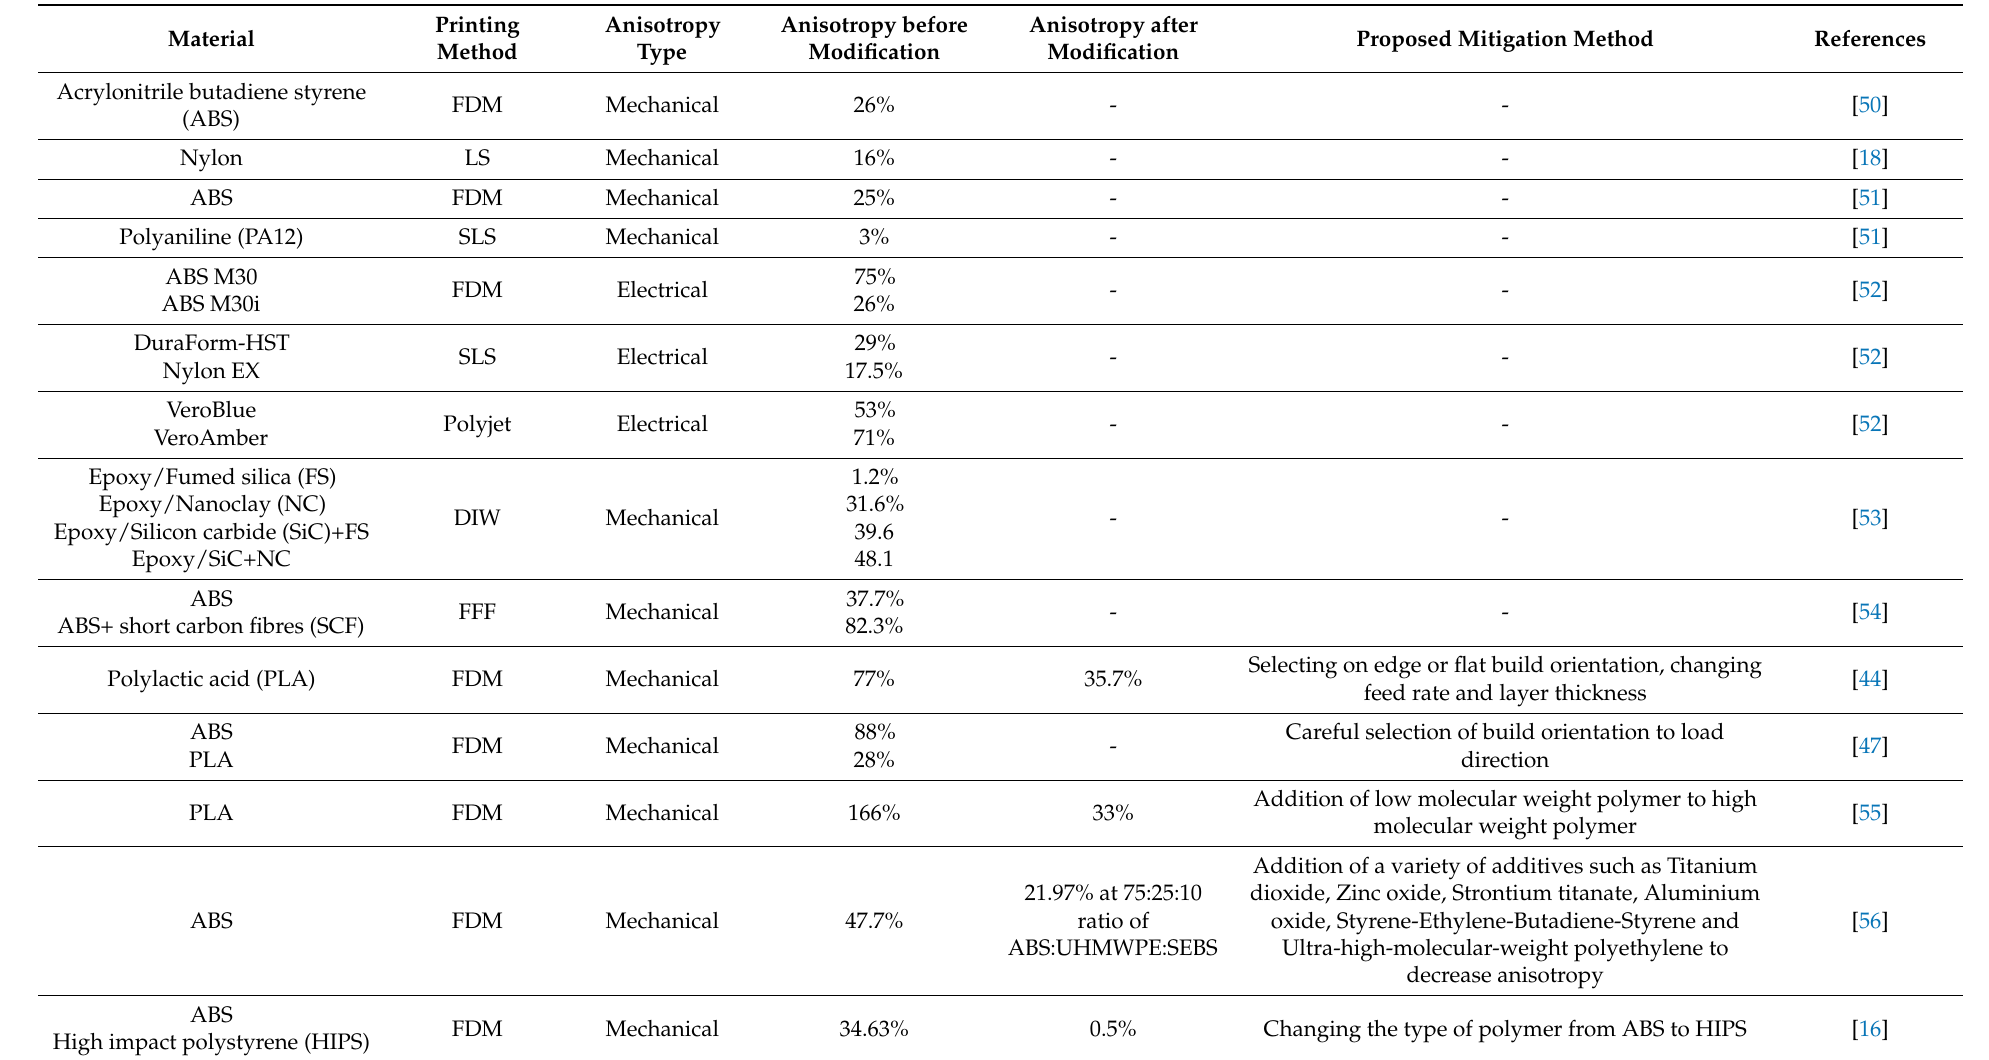
Table 2. Summary of anisotropy in polymeric parts printed by different AM